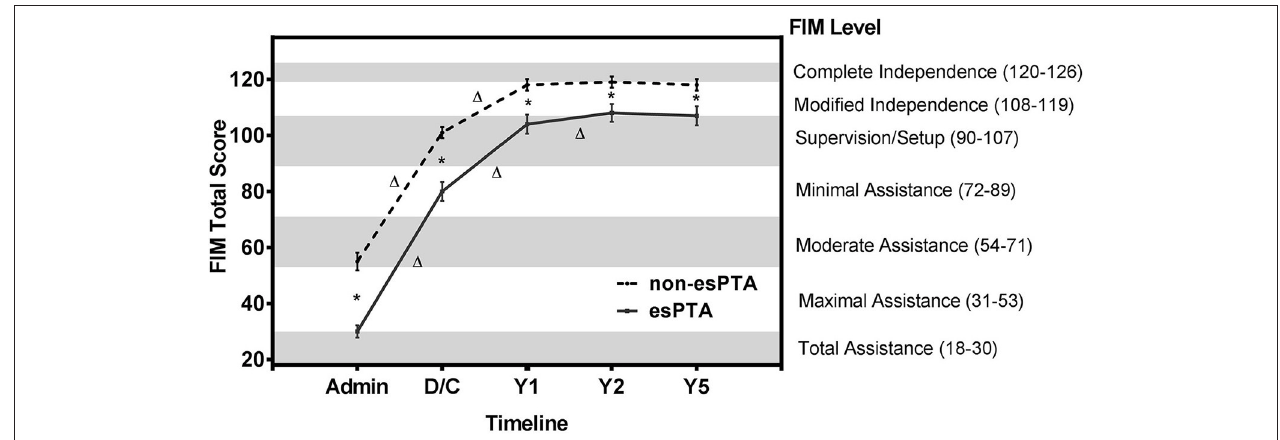
FIGURE 3 | FIM total scores of esPTA group and non-esPTA group at 5 time points. Line plot illustrates the change in FIM total scores across follow-up periods in the esPTA and non-esPTA groups. The non-esPTA and esPTA groups’s FIM scores are plotted with FIM total scores on the left y-axis and the corresponding seven FIM levels on the right y-axis with the timeline on the x-axis.*Represents a significant ( p < 0.05) difference between groups at a single time point, and 1 represents a significant ( p < 0.05) within group difference between time points. Error bars with 95% confidence intervals.